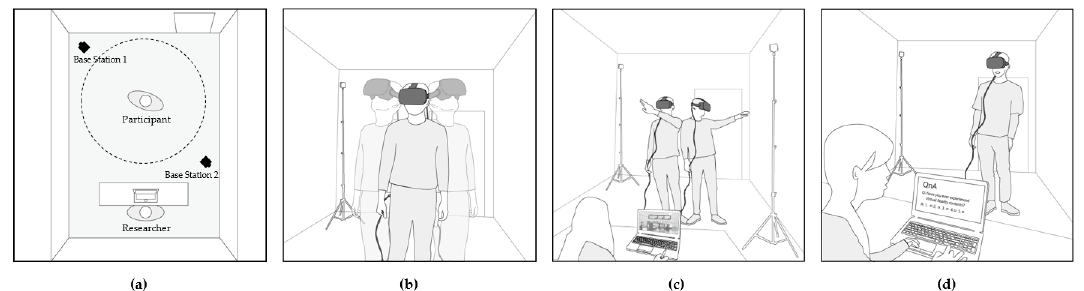
Figure 2. Experimental steps and visualization of the laboratory layout. ( a ) Layout of the virtual reality (VR) experiment. ( b ) The experimenter helps the participant wear the head mounted display (HMD) and adjusts its focus according to the nine points. ( c ) The experiment proceeds according to the visual stimulus stages. ( d ) After the VR experiment, the participant answer questions about the spatial information and their perceived